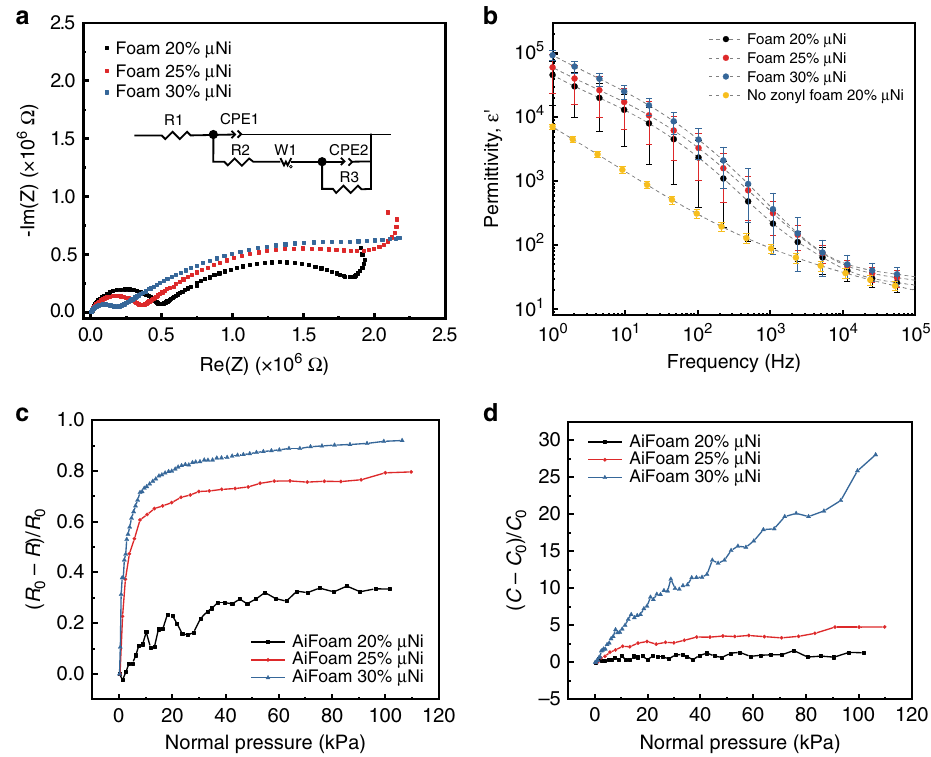
Fig. 4 Electrical performance of AiFoam. a Nyquist plots of foam materials with different volume fractional μ Ni loadings. Re(Z) represents the real part of the impedance and Im(Z) represents the imaginary part of the impedance. Inset is the equivalent circuit of the foam materials, where R 1 represents the bulk resistance; CPE 1 and R 2 represent the double-layered constant phase element (CPE) and the polarization resistance of one of the component, respectively; CPE 2 and R 3 represent the double-layered capacitance and the polarization resistance of the other component; W 1 represents the mass transport process. CPE is used to account imperfect capacitance caused by imperfect interfaces or nonuniformity (Supplementary Fig. 17). b The real part of the dielectric permittivity of foam materials with different volume fractional μ Ni loadings under the frequency range of 1 – 10 5 Hz. The error bars are calculated based on three samples. c Resistance and d capacitance change responses of AiFoam with different volume fractional μ Ni loadings under normal pressure. R 0 and C 0 represent the initial resistance and capacitance of the sensor, whereas R and C represent the resistance and capacitance of the sensor during the pressing test. The data of c , d were collected